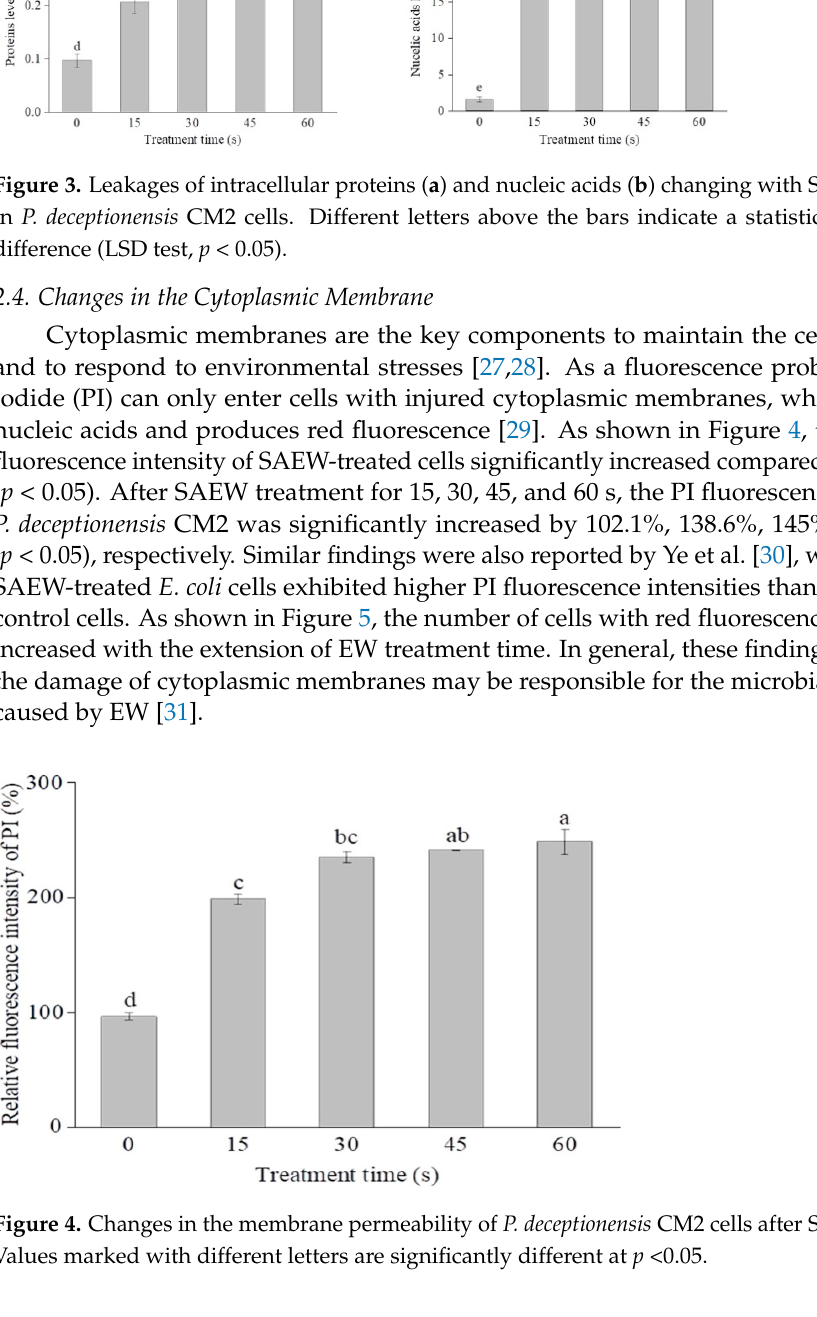
Figure 5. Fluorescence microscopic images of P. deceptionensis CM2 cells stained with propidium iodide (PI) (400×). ( a ) , ( f ): Control; ( b ), ( g ): treated with SAEW for 15 s; ( c ), ( h ): treated with SAEW for 30 s; ( d ), ( i ): treated with SAEW for 45 s; (e), ( j ): treated with SAEW for 60 s. ( a )–( e ) indicated PI staining observation ; ( f )–( j ) indicated field observation. 2.5. Changes in the Outer Membrane Permeabilization For Gram-negative bacteria, the outer membrane (OM) plays an important role in the rapid adaptation to various environmental stresses such as heat, acid, and antibiotics [32]. In this work, the n-phenyl-1-napthylamine (NPN) access assay was applied to assess the influences of SAEW on the OM permeabilization of P. deceptionensis CM2 cells. NPN is a neutral hydrophobic fluorescent probe, exhibiting low fluorescence quantum yield in an aqueous environment, but becomes strongly fluorescent in nonpolar or hydrophobic environments. Therefore, NPN is widely used to assess the damage of the outer mem- brane of Gram-negative bacteria [33]. As shown in Figure 6, SAEW treatment caused an increase in the NPN fluorescence intensity of P. deceptionensis CM2 cells. After being treated by SAEW for 15, 30, 45, and 60 s, the NPN fluorescence intensity of P. decep- tionensis CM2 cells was increased by 202%, 255%, 266%, and 271%, respectively, com- pared to the untreated cells ( p < 0.05). These data indicate that SAEW disrupted the ex- tracellular membranes of P. deceptionensis CM2 cells, which might contribute to the cell death [34]. Previous studies showed that AEW with high ORP caused the oxidation of sulfhydryl groups on cell surfaces and disturbed metabolic pathways inside the bacterial cells, which might be responsible for cell death [35,36]. In addition, active chlorine forms (Cl 2 , HOCl, and OCl − ) are the main crucial substances for the damage to outer membrane [37].